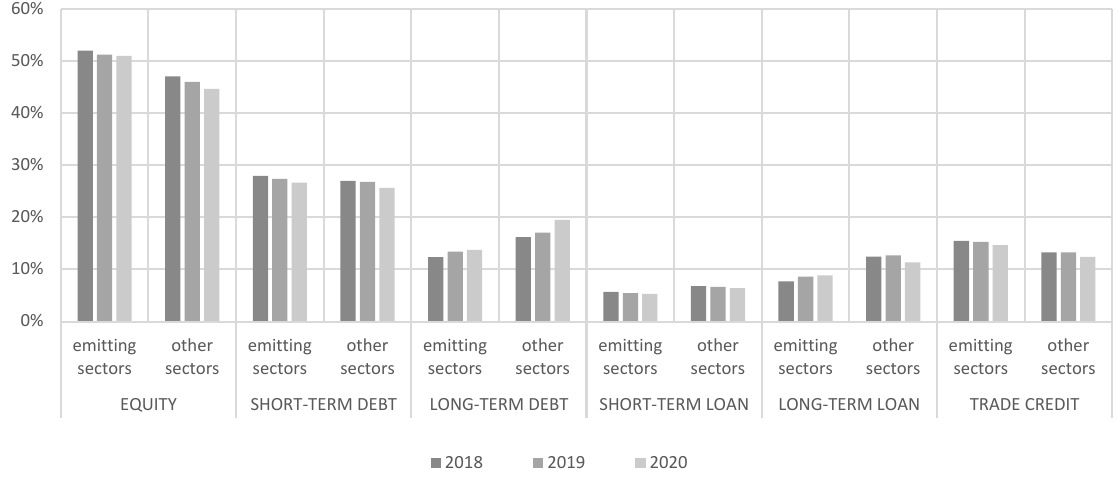
Figure 5. Financial performance measures: emitting sectors versus other sectors.